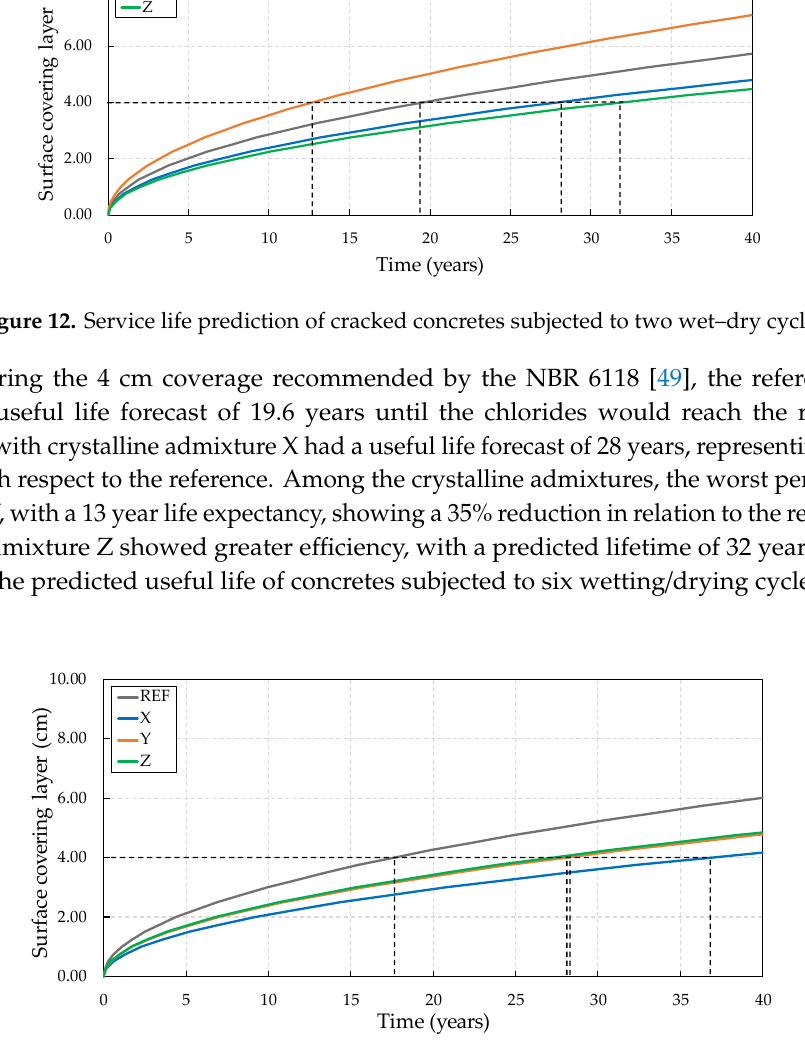
Figure 13. Service life prediction of cracked concretes subjected to six wet–dry cycles.